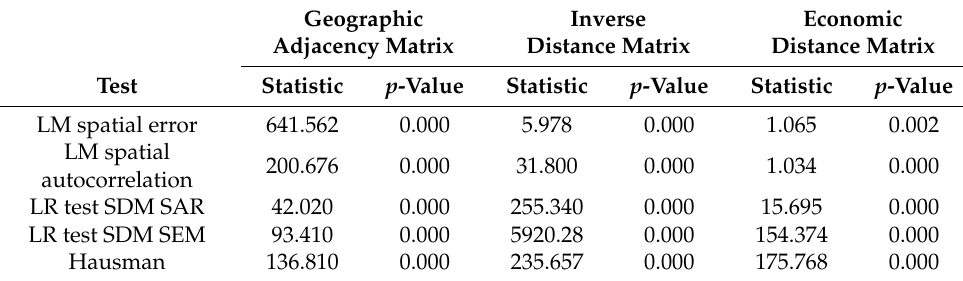
Table 4. LM, LR, and Hausman